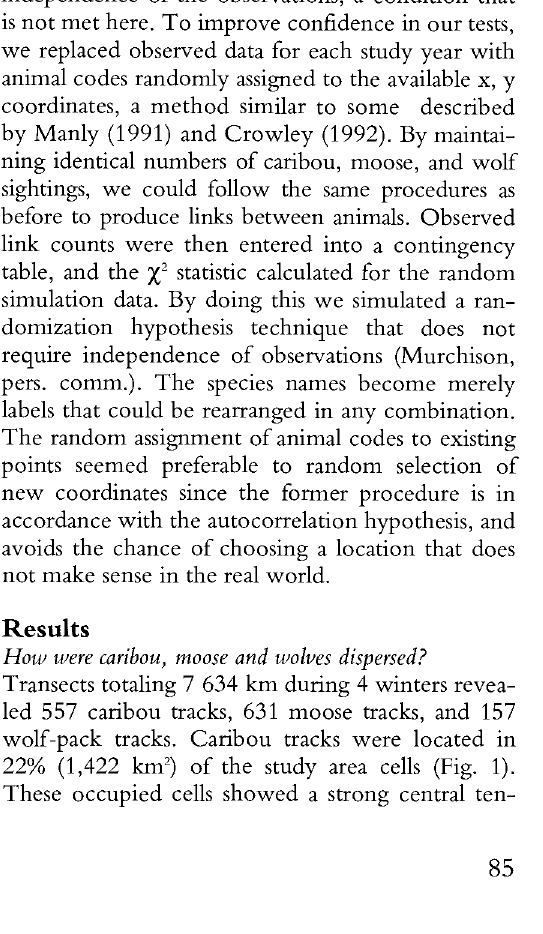
Fig. 1. Caribou track densities revealing a core area with 10+ tracks recorded during 4 winters (by 9.29 km 2 grid